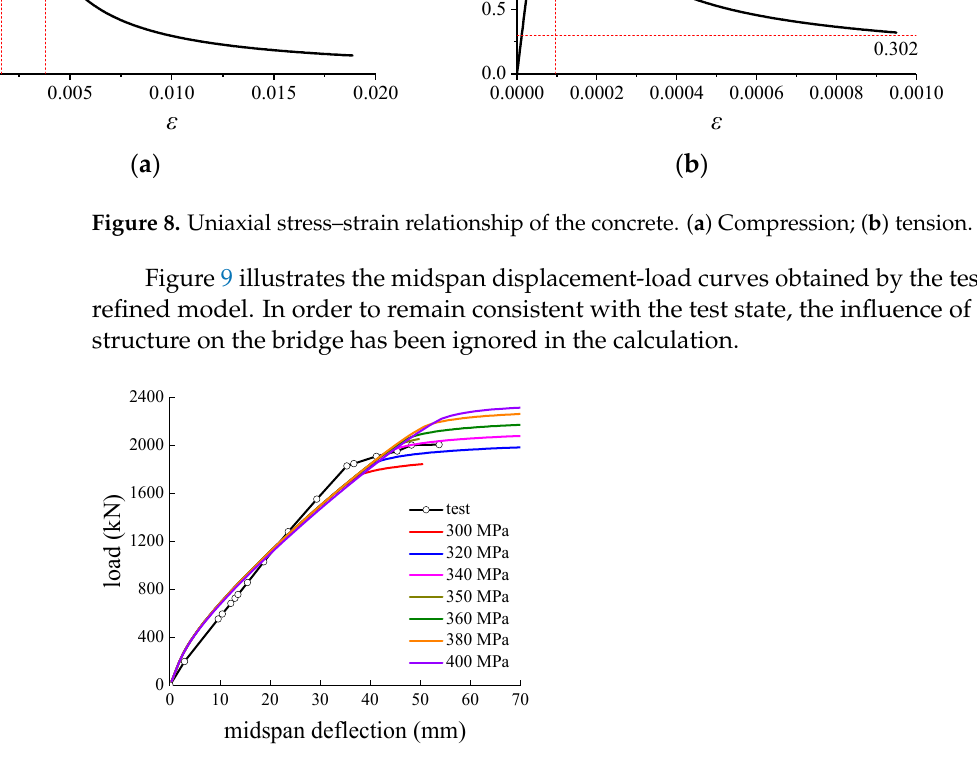
Figure 9. The achieved results from the test and the calculation model.